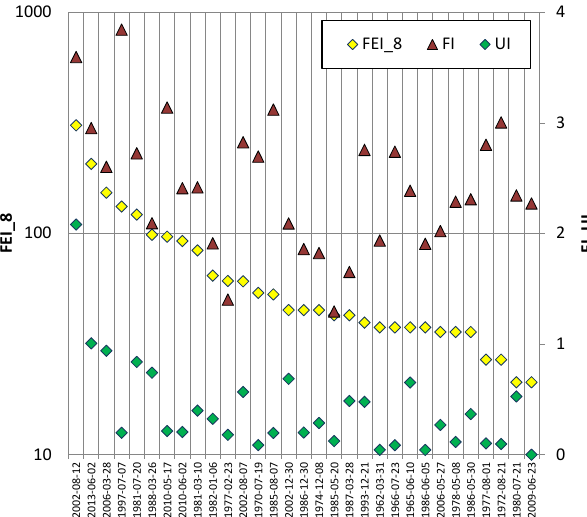
Figure 11. EFEs characterized by the FEI, the index by Uhlemann et al. (2010) (UI), and by the maximum Francou index (FI) calcu- lated within eight selected large Czech catchments.